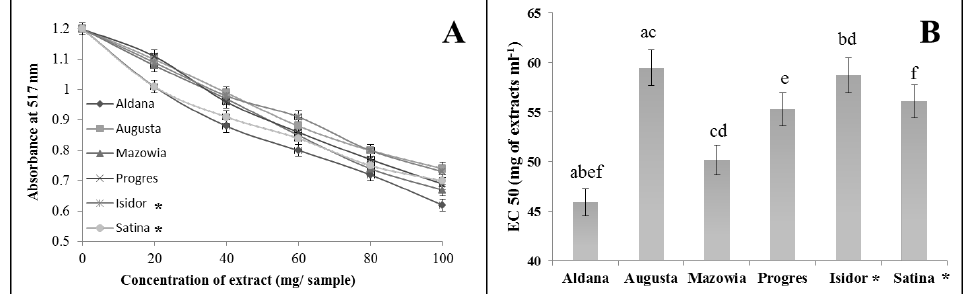
Figure 1. The capability to scavenge the free radical DPPH • by extracts from soybean seeds (A) . Half-maximal effective concentration (EC 50 ) of extracts from soybean seeds to scavenge DPPH • (B). Means with the same letters (a,b,c,d,e,f) are not significantly different ( p < 0.05). Data represent the mean ± SD of four replicates . Varieties from France are marked with an asterisk (*), while the other varieties come from Poland.